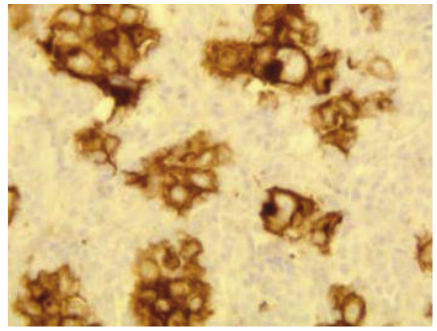
Figure 10: CD30 positivity suggestive of CHL (100x).